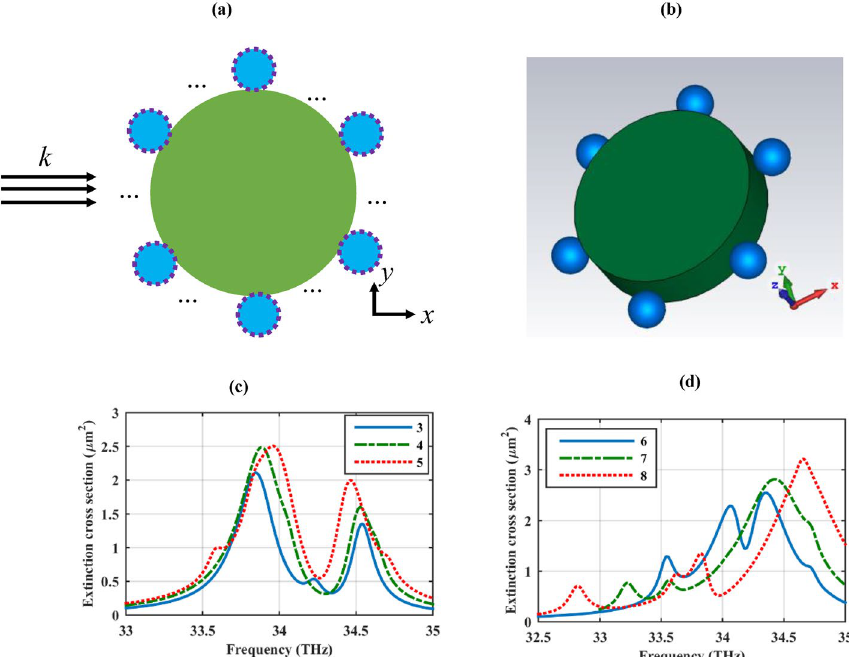
Figure 3. An array of polarizable nanoparticles with a different number of one-dimensional periodic arrays, arranged around an infinite length dielectric cylinder ( a ) 2D and ( b ) 3D views. Dashed lines represent graphene coating. The extinction cross-section considering various numbers of one-dimensional periodic arrays around the cylinder ( c ) 3–5 and ( d ) 6–8. The design parameters are as follows: r c = 500 nm, ε c = 2, r s = 100 nm, h = 250 nm, τ = 1.5 ps, and μ c = 0.5 eV. The spherical particles are considered hollow. Note that in the 3D view, only a unit cell is illustrated and the periodicity along the cylinder axis is implemented via the image theory in the